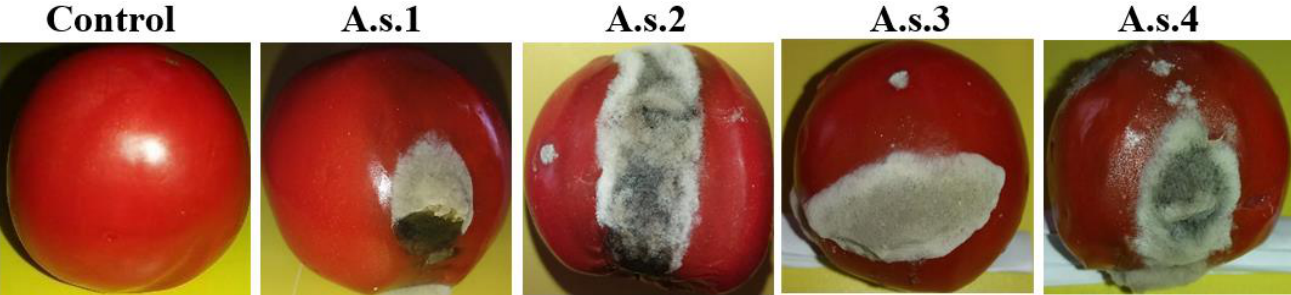
Figure 1. Artificially inoculated tomato fruits with Alternaria spp. isolates (A.s.1, A.s.2, A.s.3, and A.s.4) showing black spots and gray mycelial fungal growth compared to healthy control after one week from the inoculation.